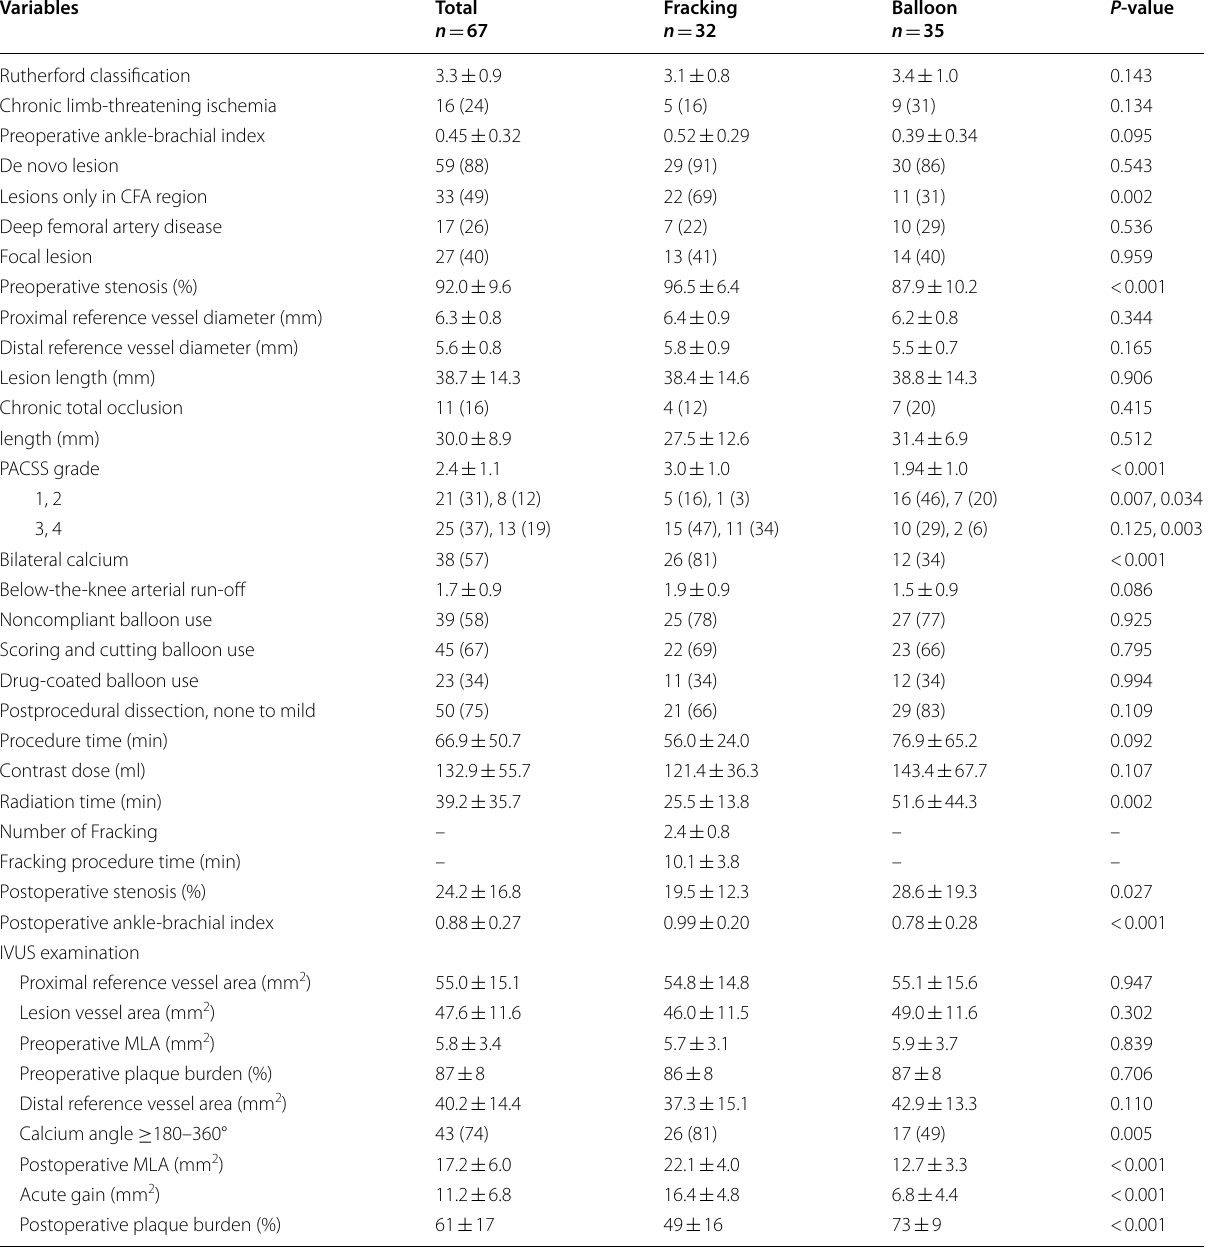
Continuous variables are indicated as mean standard deviation. Categorical variables are expressed as the counts (percentage) ± Abbreviations : CFA common femoral artery, IVUS intravascular ultrasound, MLA minimum lumen area, PACSS Peripheral Artery Calcium Scoring